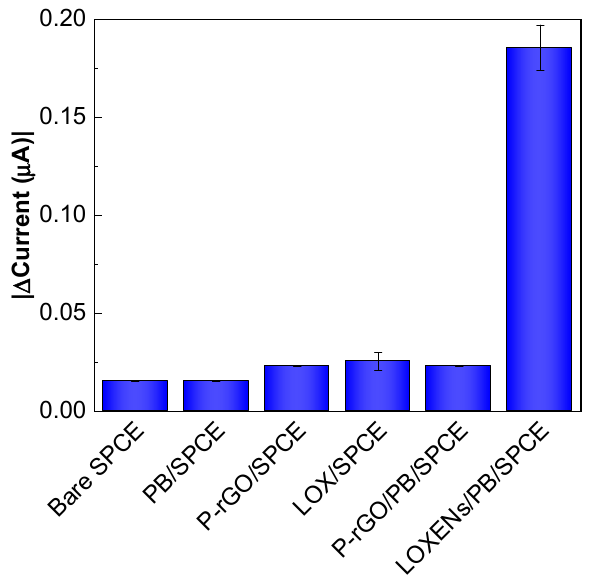
Figure 3. ( a ) CV results of the modified biosensors (bare SPCE, PB/SPCE, P-rGO/PB/SPCE, and LOX- ENs/PB/SPCE) in 5 mM K 3 [Fe(CN) 6 ] prepared in 0.1 M KCl at 50 mV s − 1 . ( b ) The corresponding i pa values plot.